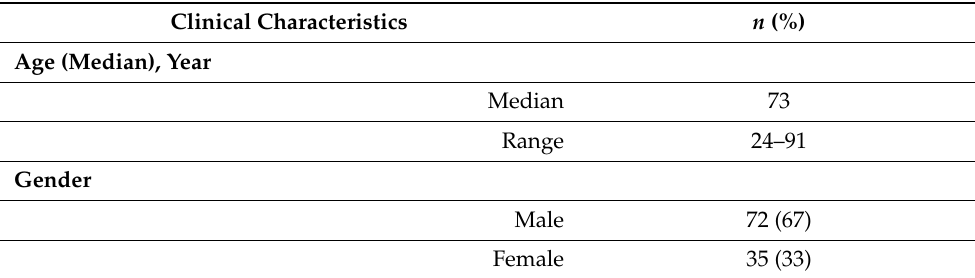
Table 1. Clinical characteristics of patients ( n = 107) with MDS with TP53